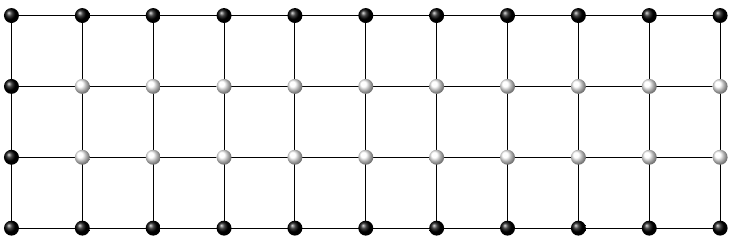
Figure 5. A minimum doubly connected dominating set of G [ 11,4 ] formed by the set of all black